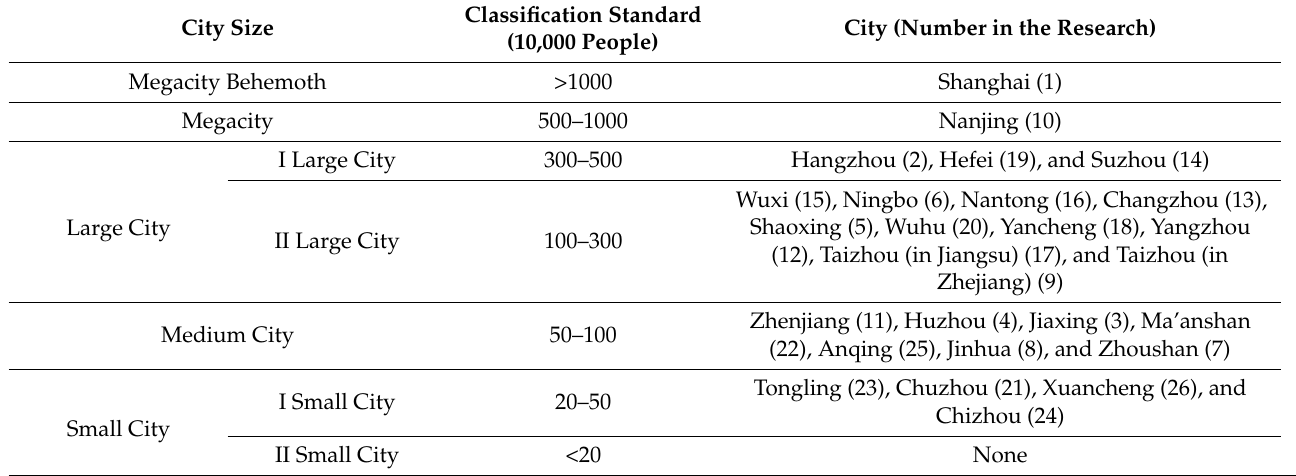
Table 1. Classification of city size in the